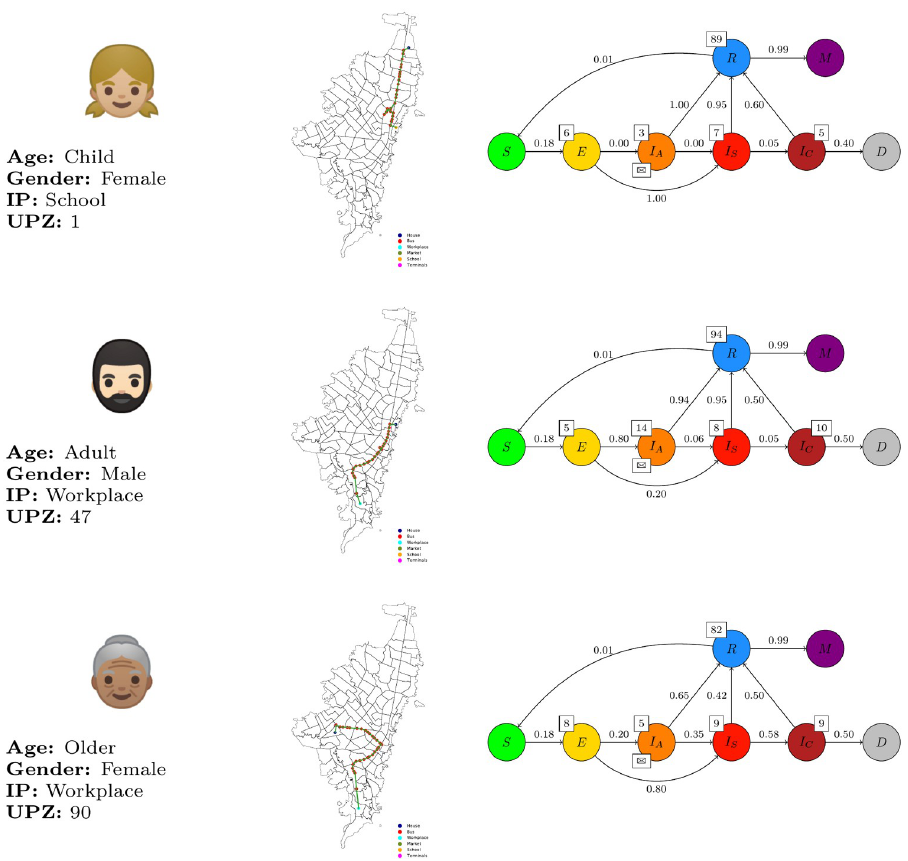
Fig 3. Example routines carried by individuals. Individual 38 (top): [Child, F, School, 1]; Individual 73128 (middle): [Adult, M, Workplace, 47]; Individual 349915 (bottom): [Older, F, Workplace, 90].